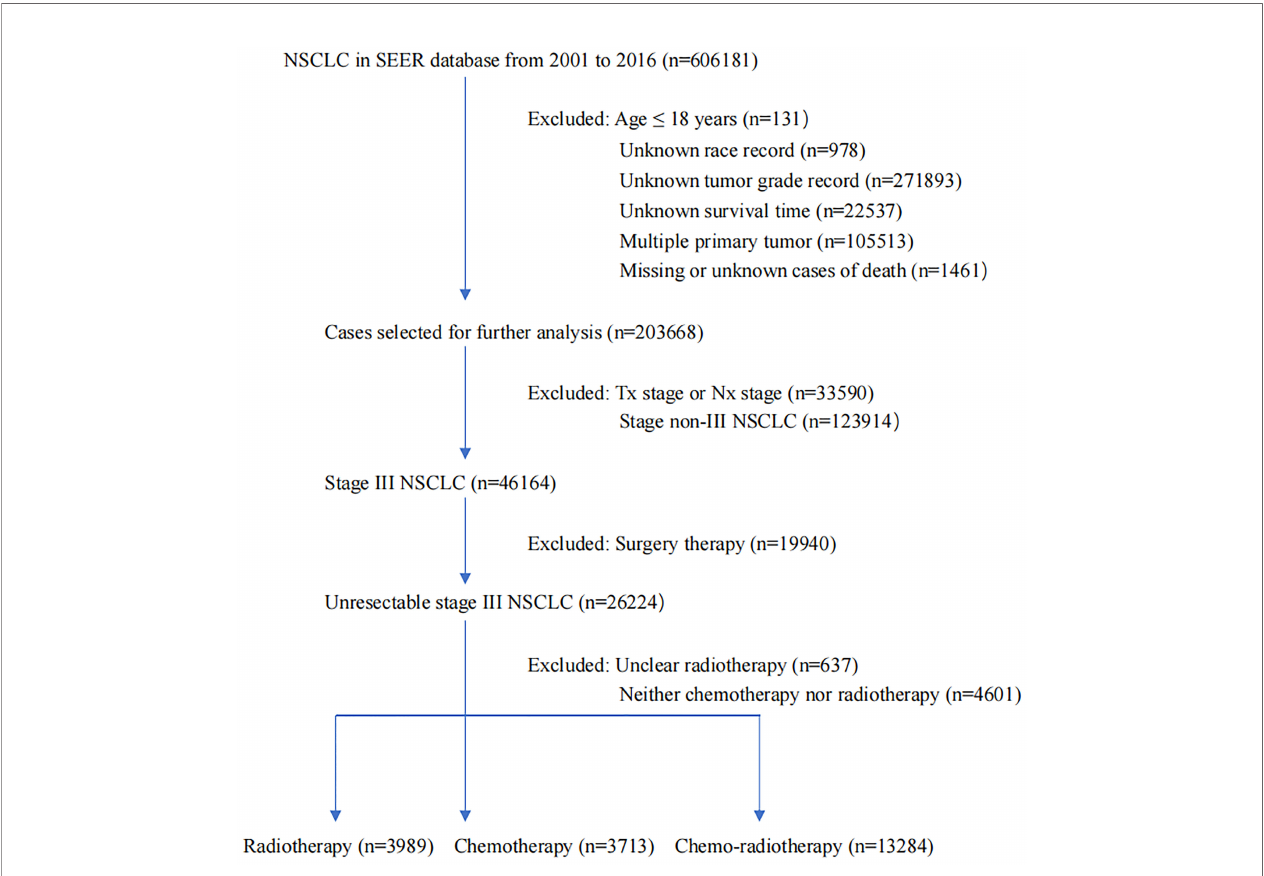
FIGURE 1 | The fl owchart of study population